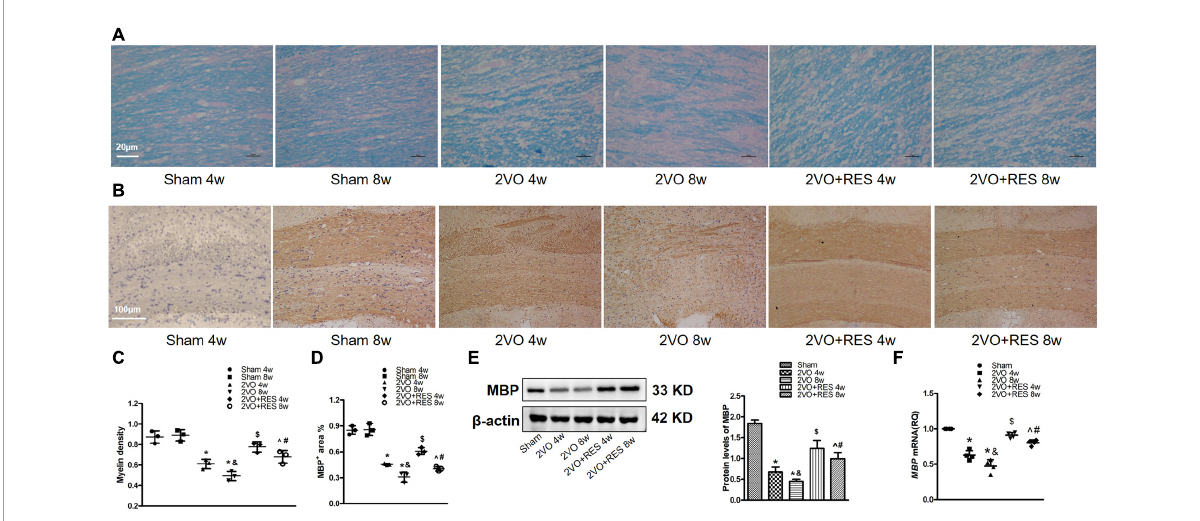
FIGURE3 Resveratrol (RES) attenuates white matter damage in corpus callosum after bilateral common carotid artery occlusion (2VO). (A) Luxol fast blue (LFB) staining in the corpus callosum at 4 and 8 weeks after 2VO ( n = 3 per group, × 400, scale bar, 20 µ m). (B) Representative immunostaining for myelin basic protein (MBP) staining in the corpus callosum in different groups ( n = 3 per group, × 100, scale bar, 100 µ m). (C) Myelin density in each group is presented by the percentage of LFB-stained area in a total area of the corpus callosum. (D) Quantitation of the percentage of MBP positive area in the corpus callosum. (E) Left, western blots of MBP from white matter extract. right, quantification of western blot analysis of MBP after 2VO. β -actin was used as a loading control ( n = 3 per group). (F) Quantification of mRNA levels of MBP. GAPDH was used as an internal control ( n = 4 per group). * p < 0.05 vs. Sham; & p < 0.05, 2VO 8w group vs. 2VO 4w group; # p < 0.05, 2VO + RES 8w group vs. 2VO + RES 4w group; $ p < 0.05, 2VO + RES 4w group vs. 2VO 4w group; ˆ p < 0.05, 2VO + RES 8w group vs. 2VO 8w group. Data are presented as mean ± SD.